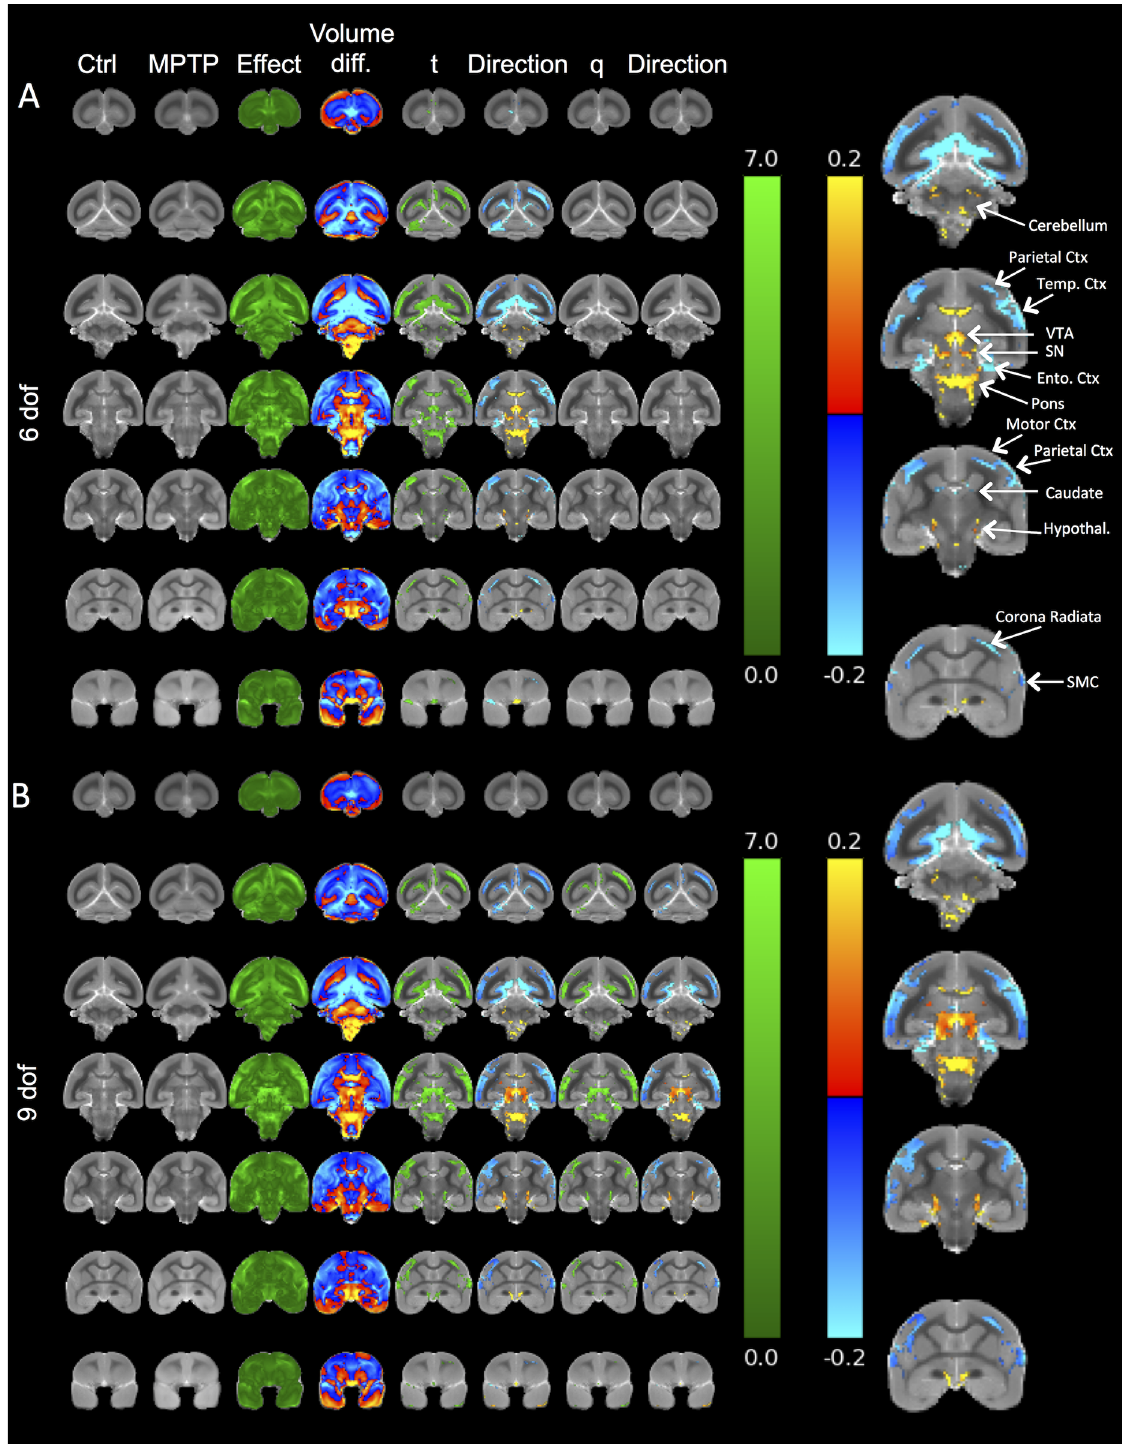
Fig 5. Tensor-based morphometry (TBM) of T 2 -weighted images to contrast anatomical changes in MPTP-treated marmosets. Color scales are for volume difference (green), the raw t-statistical value at each voxel and the directionof the change(warm colors = expansion, cold colors = atrophy). Volume changeswhich survive multiple comparisons corrections across all voxels in the brain (False DiscoveryRate with q < 0.05)are also shown. A. 6 degreesof freedom (dof) TBM revealslocal changes,but does not control for brain size differences. The t maps revealsub-regional changesin the MPTP-treated animals